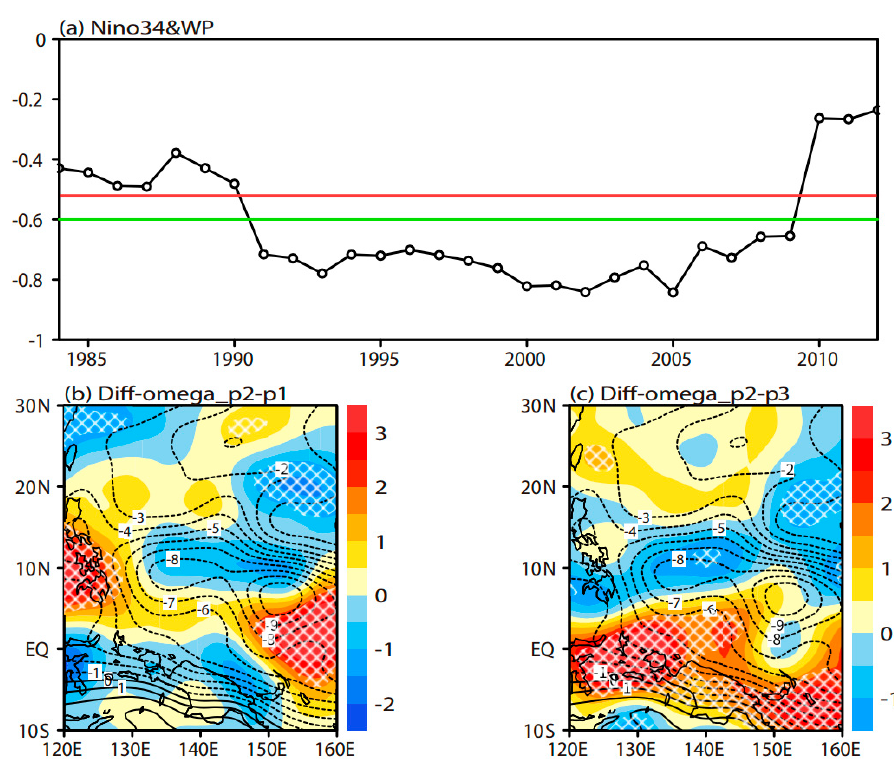
Figure 11. ( a ) 11-year sliding correlation of the Niño3.4 index and regionally averaged (100° E–160° E, 10° N – 20° N) western Pacific region summer vertical velocity index (WPOI) at 500 hPa during 1979 – 2017, where the red and green horizontal lines denote the 90% and 95% confidence levels of the correlation coefficient, respectively; ( b ) Difference in vertical velocity at 500 hPa (unit P/s) between P2 and P1 (shaded region); ( c ) Difference in vertical velocity at 500 hPa (unit P/s) between P3 and P1(shaded region). The contour represents the climatology of the vertical velocity at 500 hPa. The vertical velocity has been multiplied by 100. The gridded regions indicate that the vertical velocity anomalous are positively and negatively significant at the 95% confidence level.